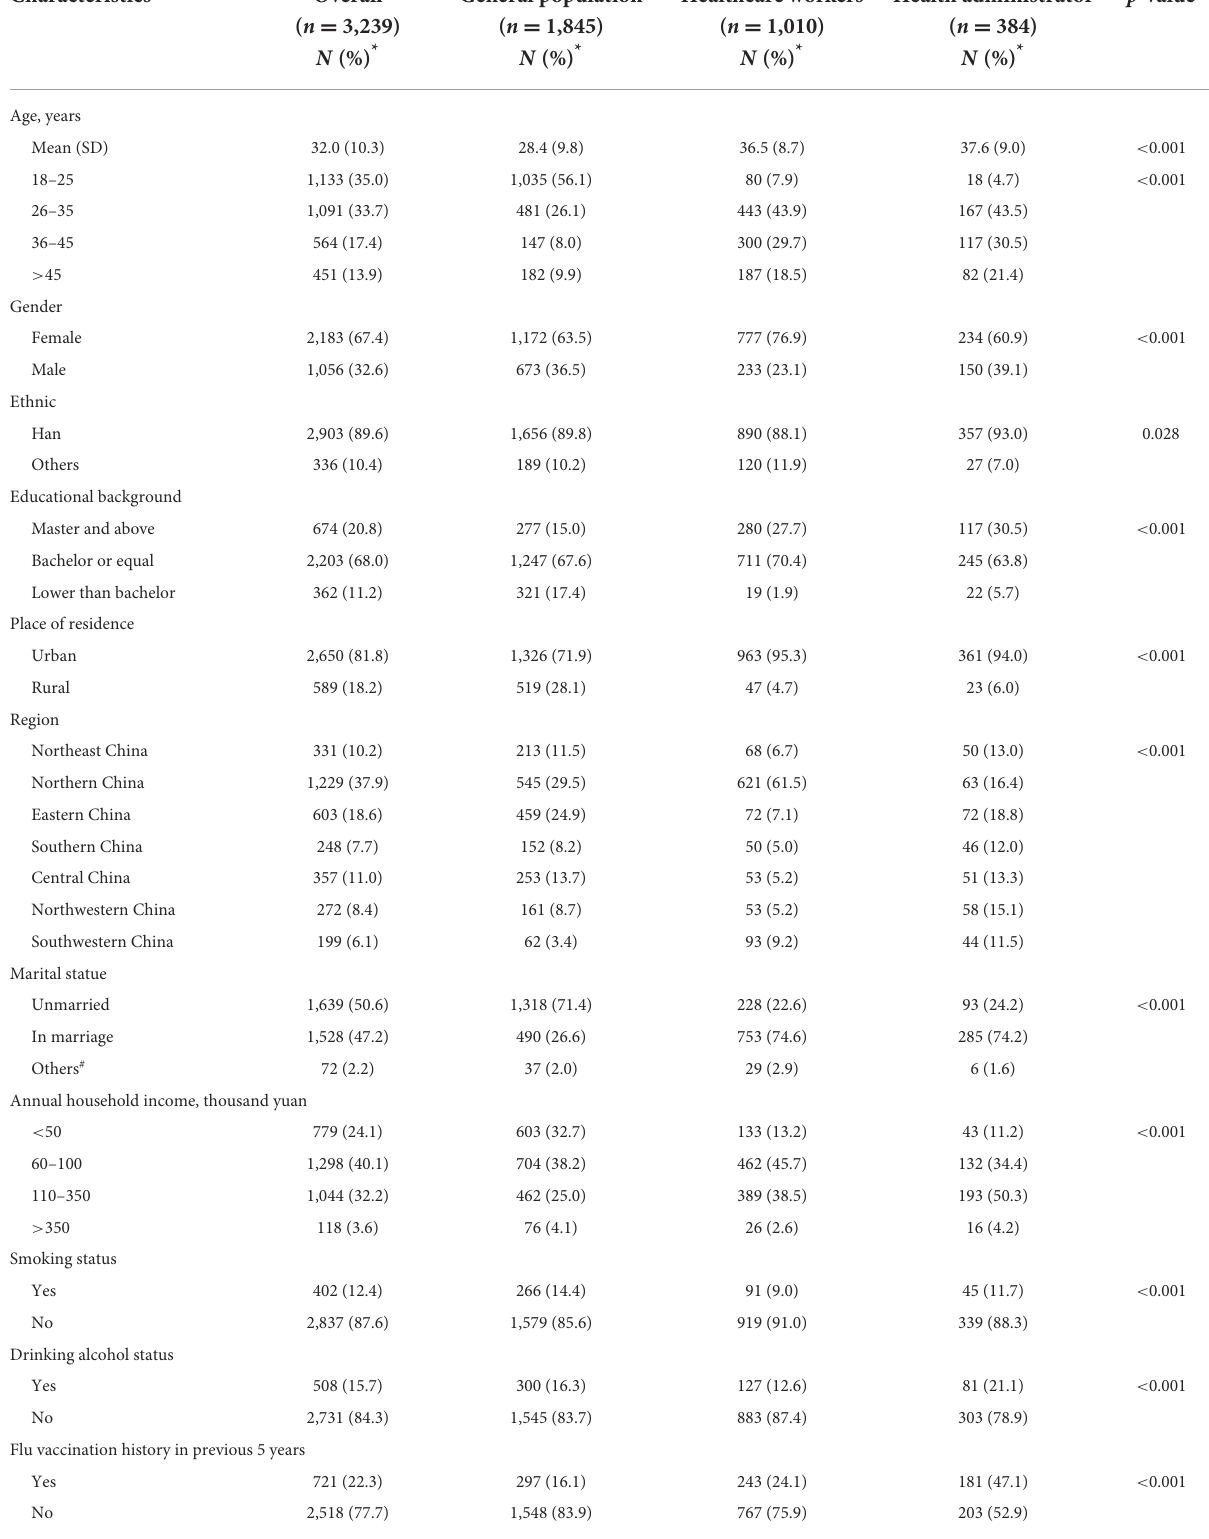
TABLE 1 Participant characteristics and their attitude toward influenza vaccines.